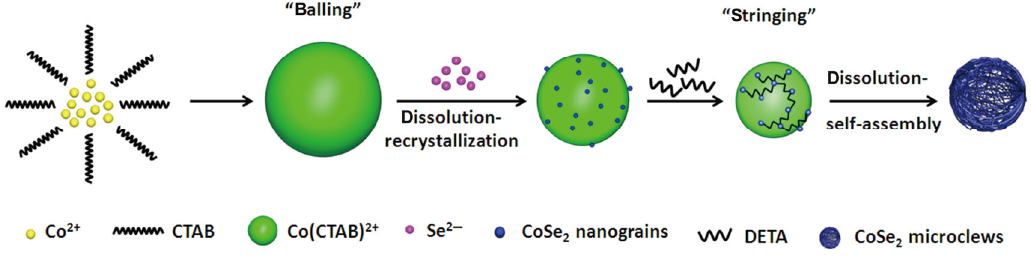
Fig. 6 Schematics of the formation mechanism of hierarchical CoSe 2